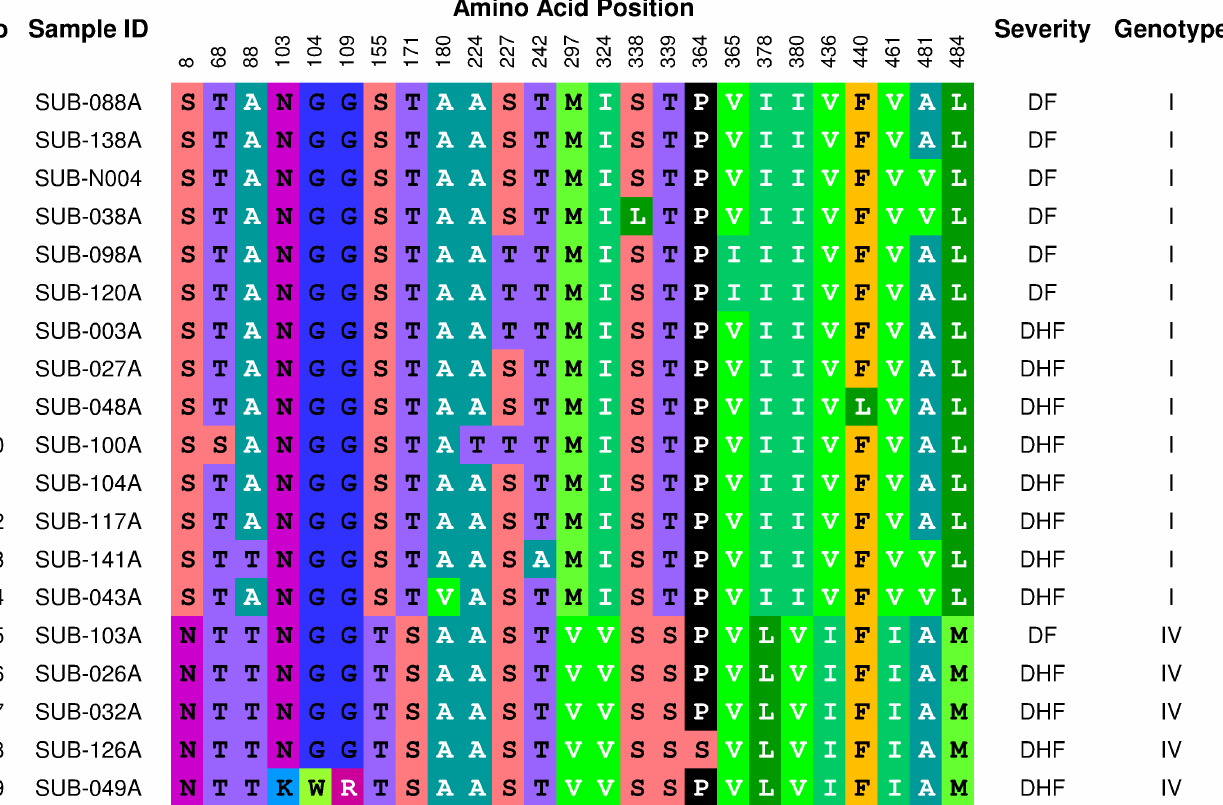
PLOS ONE | https://doi.org/10.1371/journal.pone.0178443 June 2,